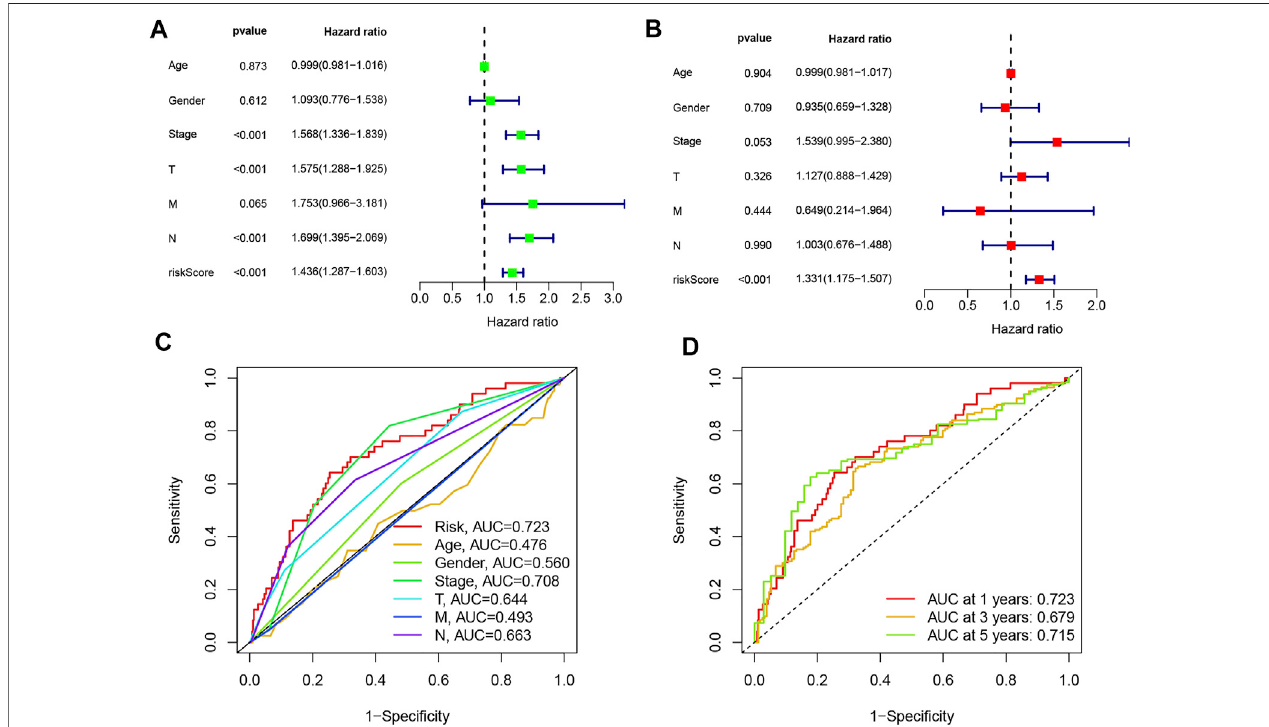
FIGURE4| Validationofthepredictivevalueoftheprognosticsignature. (A) Uni-Coxand (B) multi-Coxregressionanalysesofclinicalcharacteristicsandriskscore with overall survival. (C) Comparison of the prediction accuracy of the risk model with clinicopathological features, such as age, gender, stage, T stage, M stage, and N stage. (D) Accuracy of the risk signature in predicting 1-, 3-, and 5-year receiver operating characteristic curves based on the entire